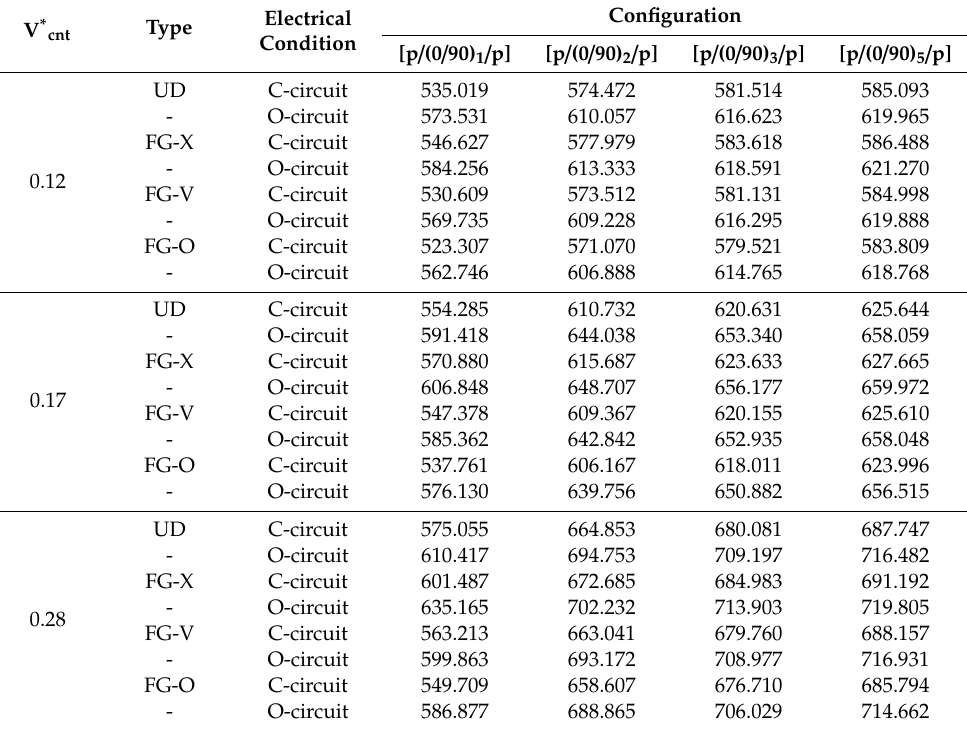
Table 8. The fundamental natural frequency ω (Hz) of anti-symmetric cross-ply [p / (0 / 90) n / p] laminated